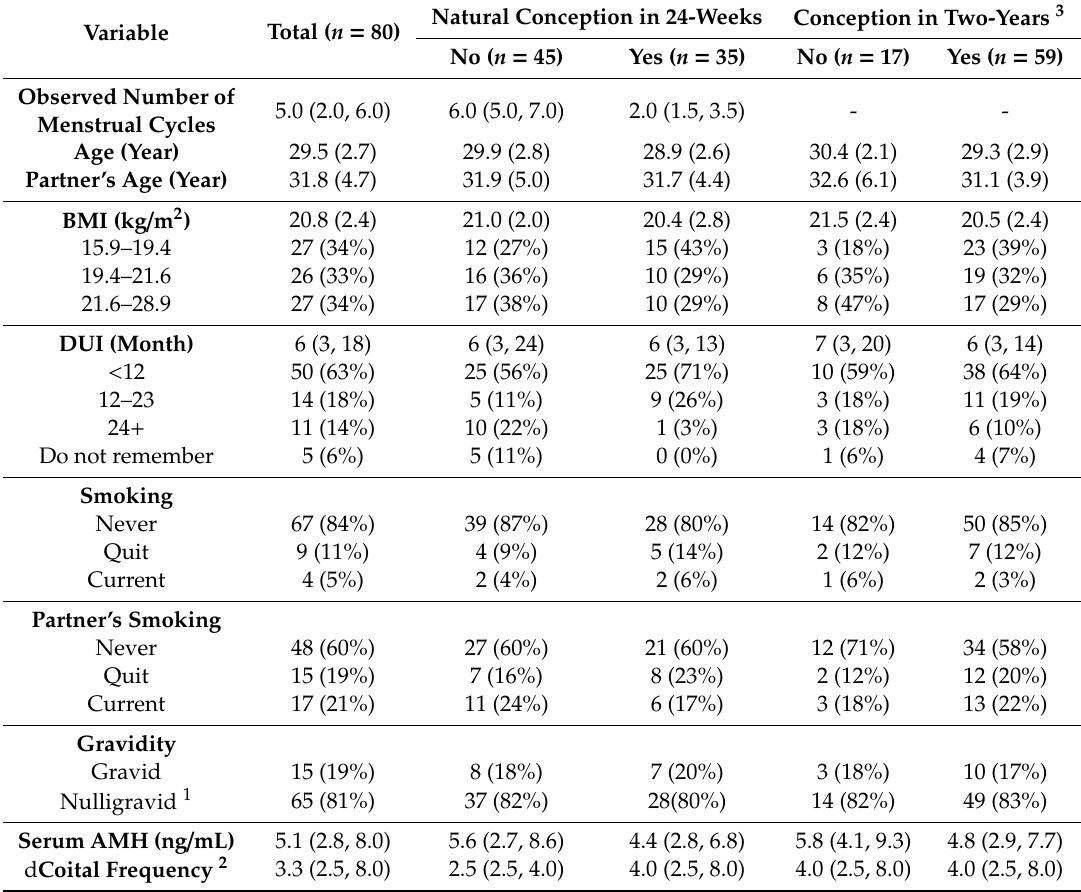
Table 1. Individual characteristics of the participants ( n = 80) in the Baby Machi study by natural conception during 24-weeks follow-up, and any conception (natural or assisted) during 2 year follow up. Median (interquartile range), mean (SD), or n